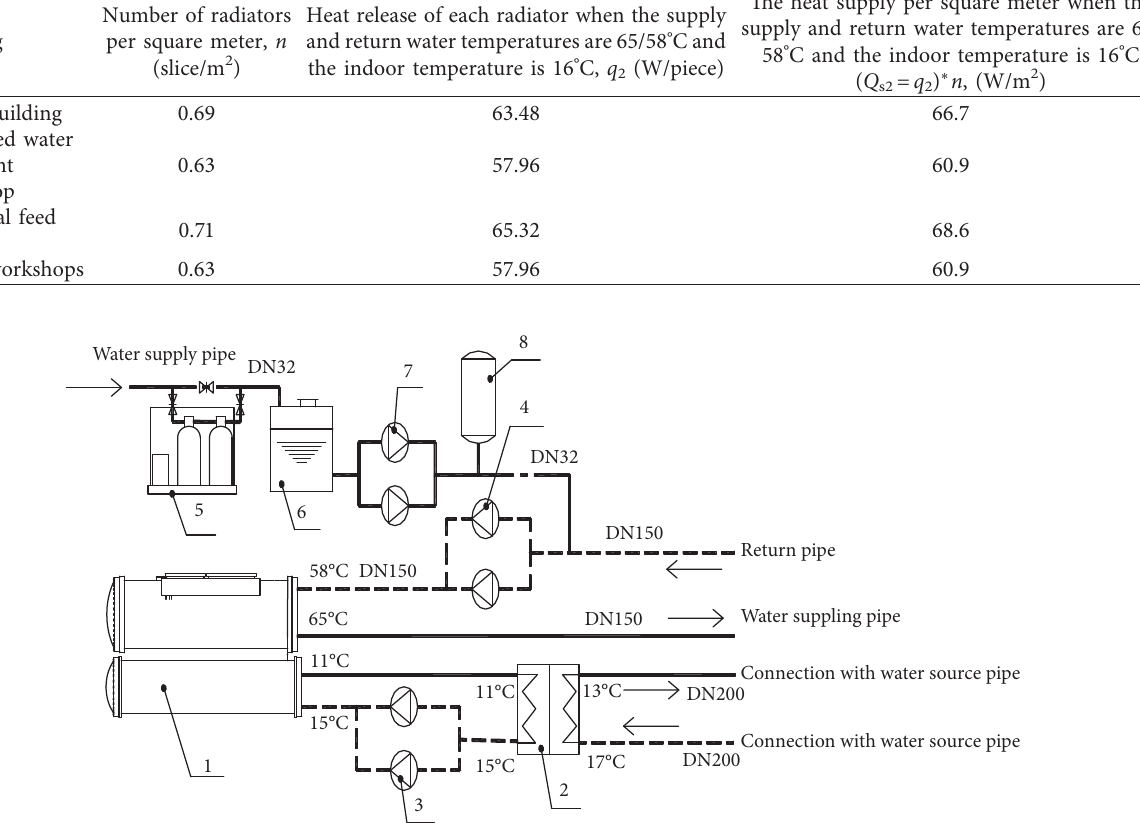
Figure 1: Flow chart of water source heat pump